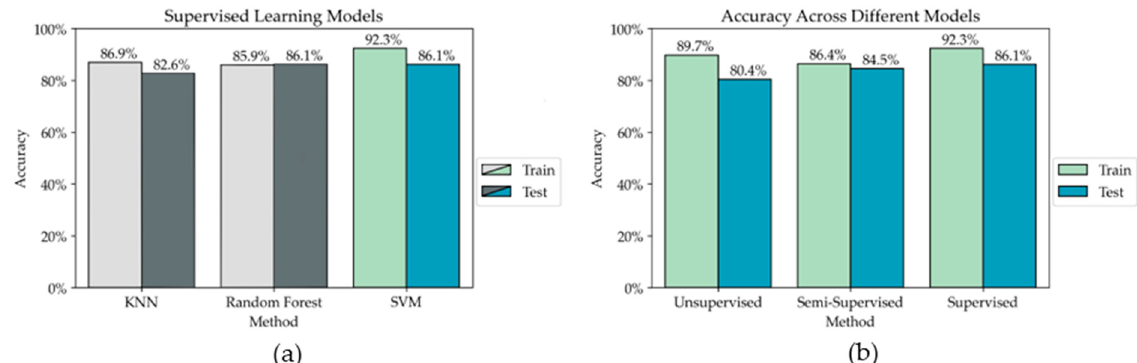
Figure 8. ( a ) Results of three supervised learning model. The best model is shown in green and blue. ( b ) Results using unsupervised learning, semi-supervised learning, and supervised learning.